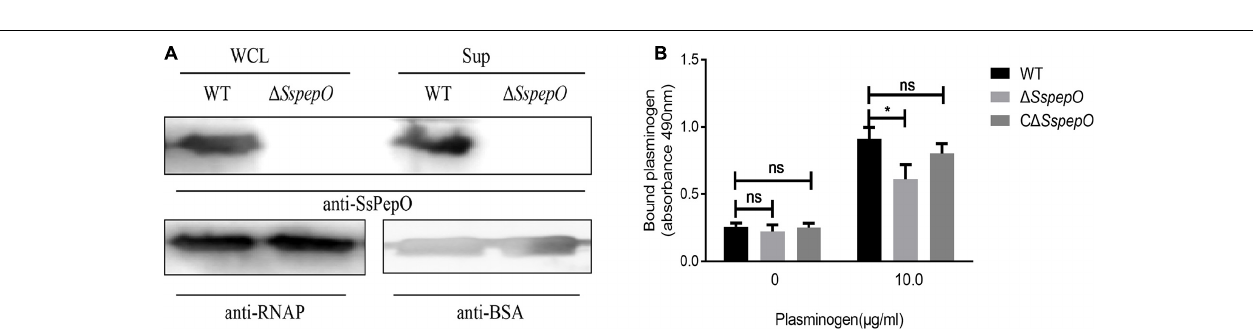
FIGURE 4 | Evaluation of the functionality of SsPepO-bound plasminogen. (A) SsPepO (5 µ g/well) was immobilized on a microtiter plate. After blocking, these samples were incubated with plasminogen (1 µ g/well) in the absence or presence of the urokinase plasmin activator (uPA) together with the chromogenic substrate S-2251. The absorbance at 405 nm was measured to assess conversion of the substrate by the generated plasmin. (B) Microtiter plates coated with SsPepO (5 µ g/well) were incubated with plasminogen (5 µ g/well) followed by addition of uPA (10 units/well) and 125I-C3b, and they were incubated at 37 ◦ C. Samples were taken at the indicated timepoints for measurement of C3b degradation. An arrow marks the cleavage products of C3b.